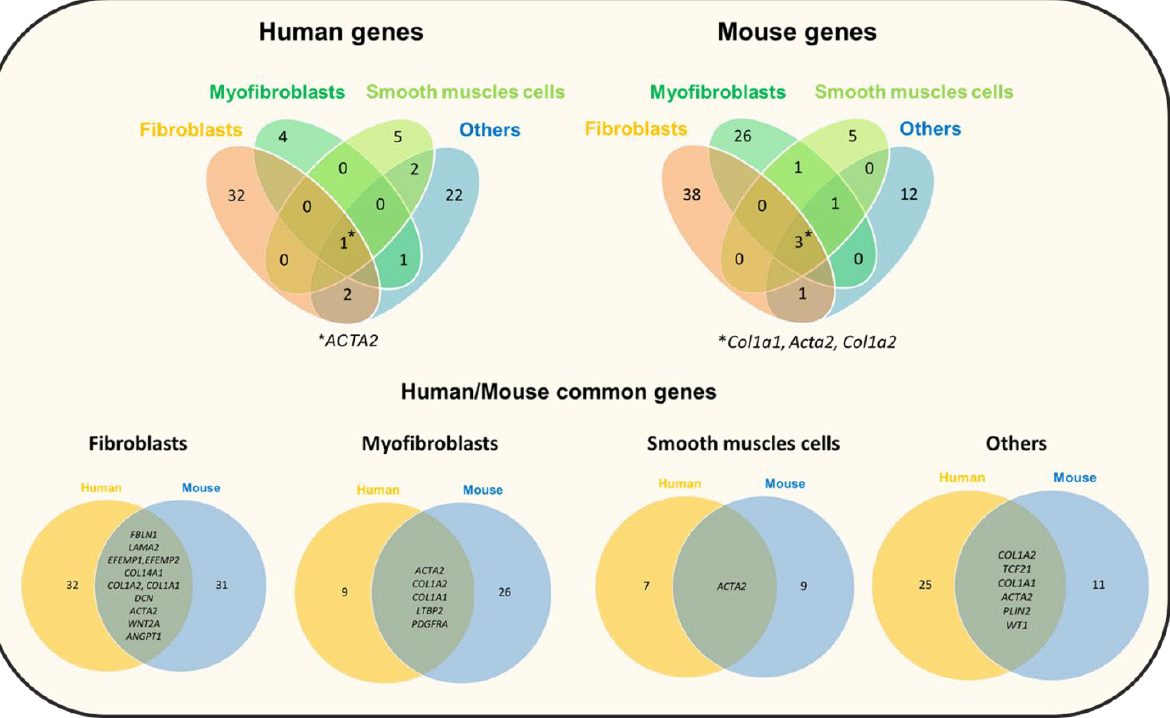
Figure 4. Venn diagrams showing the number of differentially expressed genes in each comparison (between human and mouse) and the overlaps between the four main compared mesenchymal cell types (fibroblasts, myofibroblasts, smooth muscle cells and other cell types). 1* and 3*, number of genes shared by the four cell types. This analysis is based on data from eight single-cell RNA sequencing studies (see Figure 1). The Venn diagrams were generated using the Venny tool.